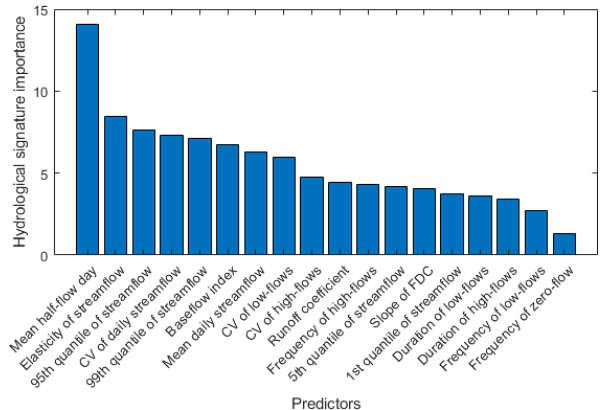
Figure 14. Hydrological signatures as predictors of the hydrologic disturbance index. The random forest regressor algorithm assesses how much each signature increases the error of an HDI predic- tion when randomly sorted. The higher the deviation caused by a predictor, the higher the influence of the hydrological signature on the